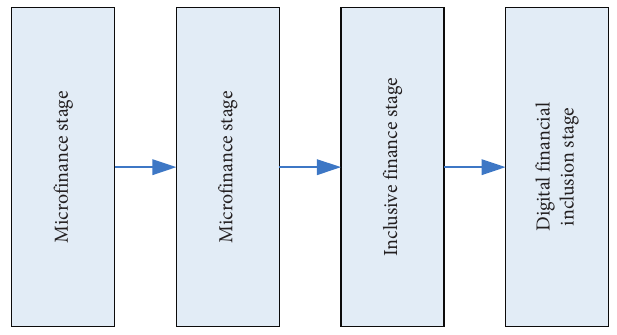
Figure 4: Development stage of digital financial